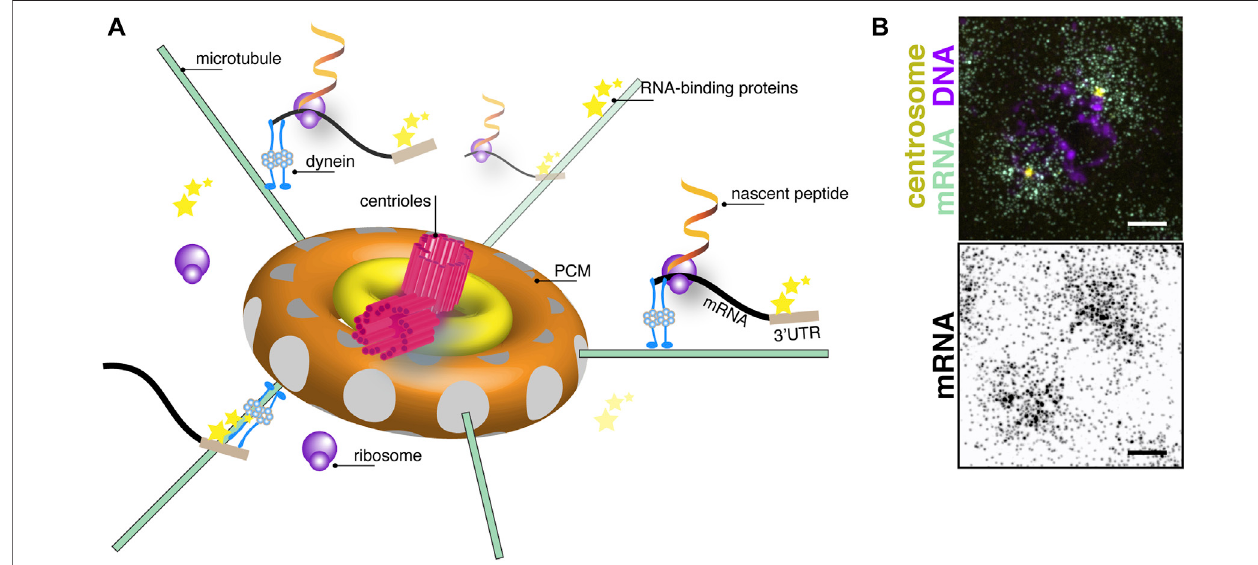
FIGURE 1 | The centrosome as a center for translational control. (A) Cartoon schematic of centrosome organization showing a central pair of centrioles (magenta) with 9-fold radial symmetry of microtubule triplets surrounded by subconcentric rings of PCM (yellow and orange toroids). Microtubule fi laments (green lines) are anchored with their minus-ends docked within c -tubulin ring complexes (grey circles) embedded within the PCM. A model mRNA (black) recognized by RNA-binding proteins (stars) binding toits 3 ′ -untranslated region (UTR; brown box) isshown undergoing active translation by ribosomes (purple circles). Nascent peptides ( fi ery ribbons) emergenearthecentrosome.Note,objectsarenotdrawntoscale. (B) Imageshowssinglemolecule fl uorescence insitu hybridizationfor plp mRNA(green)ina prophase (DNA, magenta) syncytial Drosophila embryo. plp mRNA coalesces around centrosomes (yellow). Image below shows an inverted display of the mRNA channel to maximize contrast. Bar: 5 μ m. Image courtesy of Dr. Junnan Fang, Ph.D.